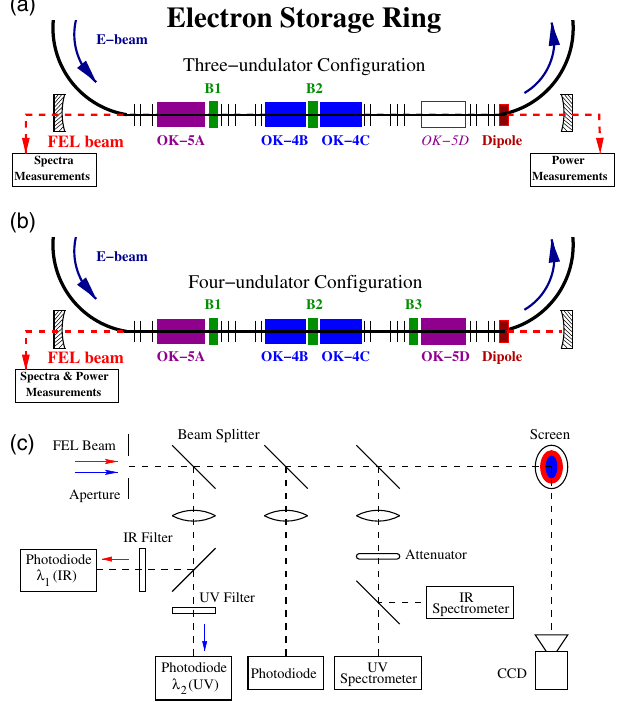
FIG. 1. Two different undulator configurations for the two- color operation. (a) Three-undulator configuration with the helical OK-5A undulator lasing in IR and the OK-4 optical klystron lasing in UV; (b) Four-undulator configuration with two OK-5 undulators (OK-5A and OK-5D) working as an optical klystron to replace the single OK-5A undulator in (a); (c) A schematic layout of a set of typical optical diagnostics for the two-color FEL